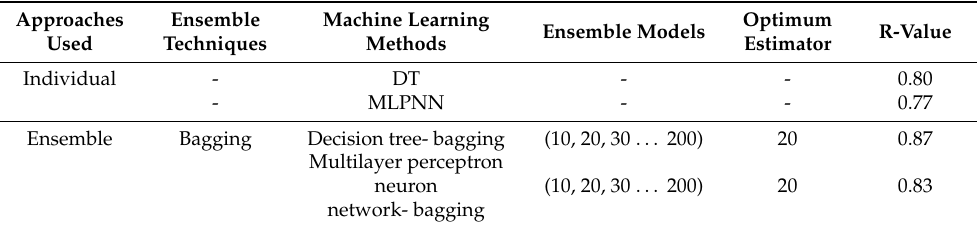
Table 5. Detailed information of the sub-models of ensemble